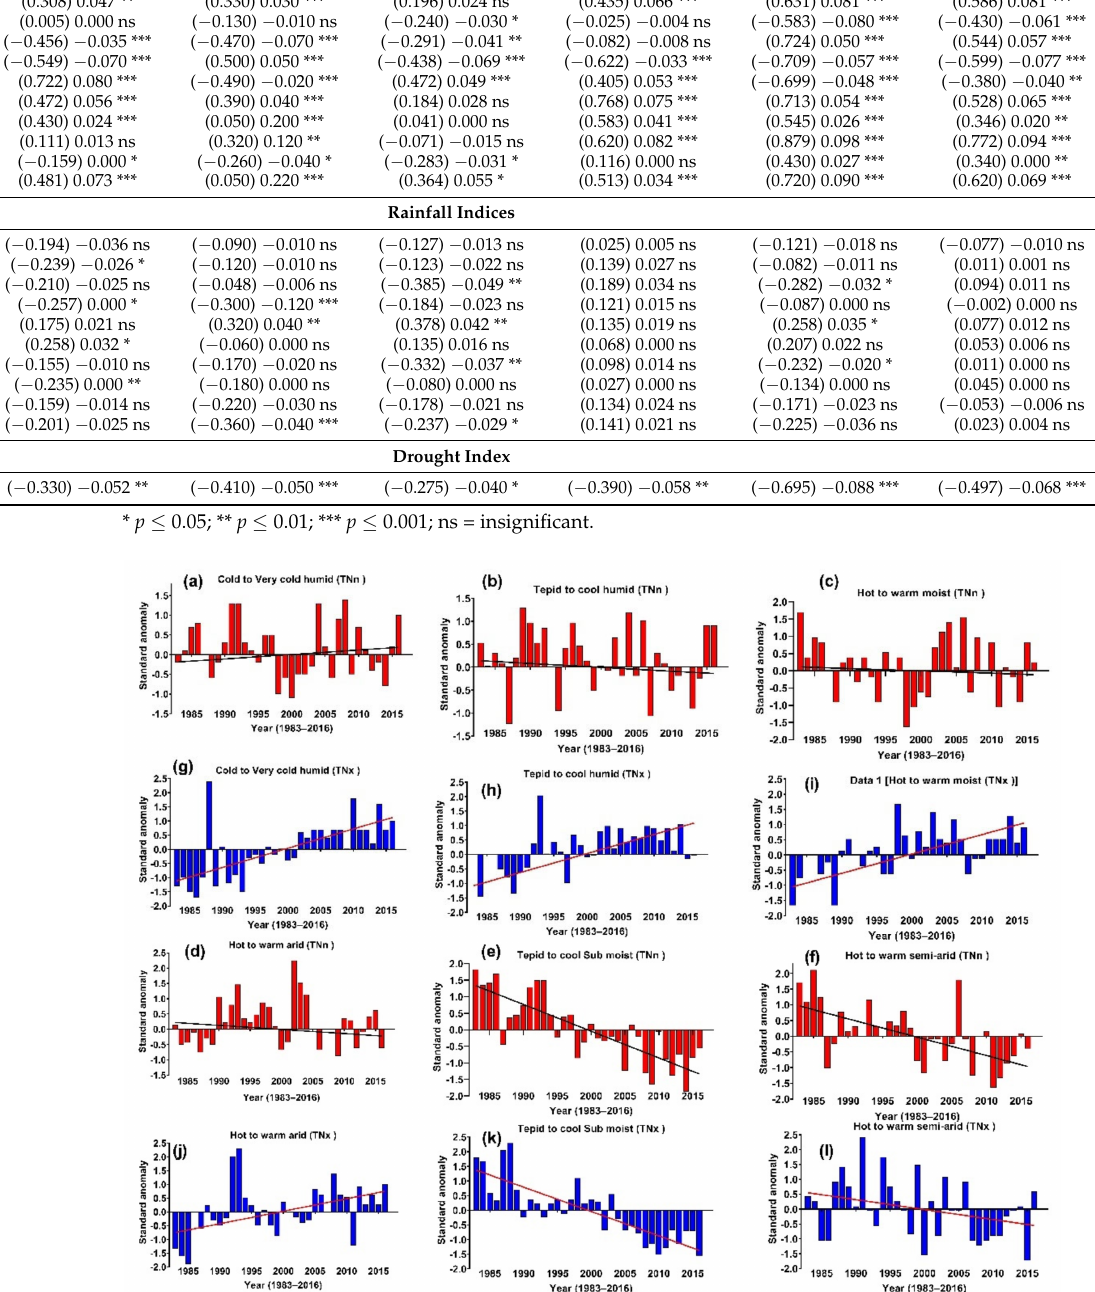
Figure 3. Coldest night (TNn) ( a – f ) and warmest night (TNx) ( g – l ) over agroecological zones for the period